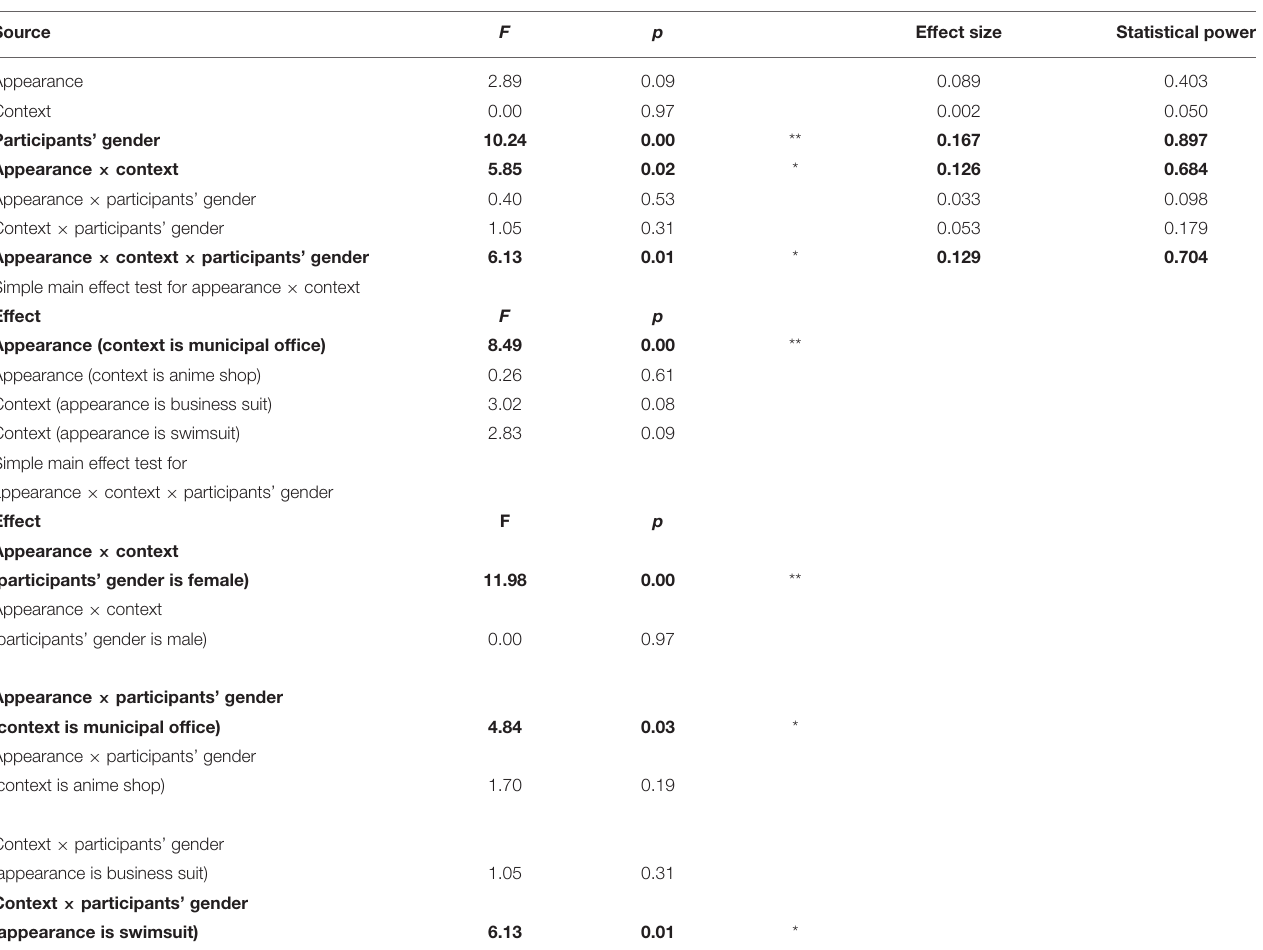
TABLE 5 | Results of three-way ANOVA, simple main effect test for appearance × context, and simple main effect test for appearance × context × participants’ gender for Q2